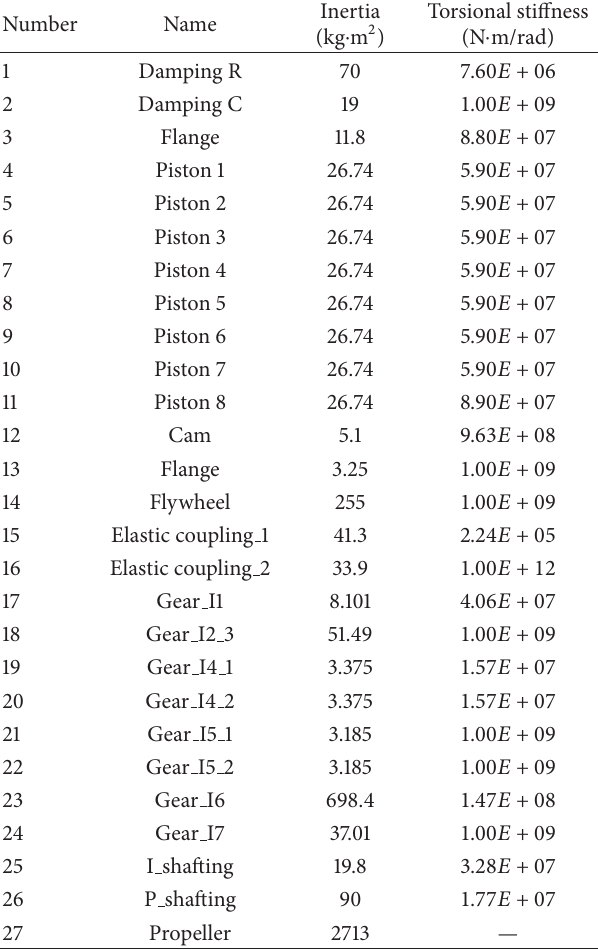
Table 1: Equivalent simplified